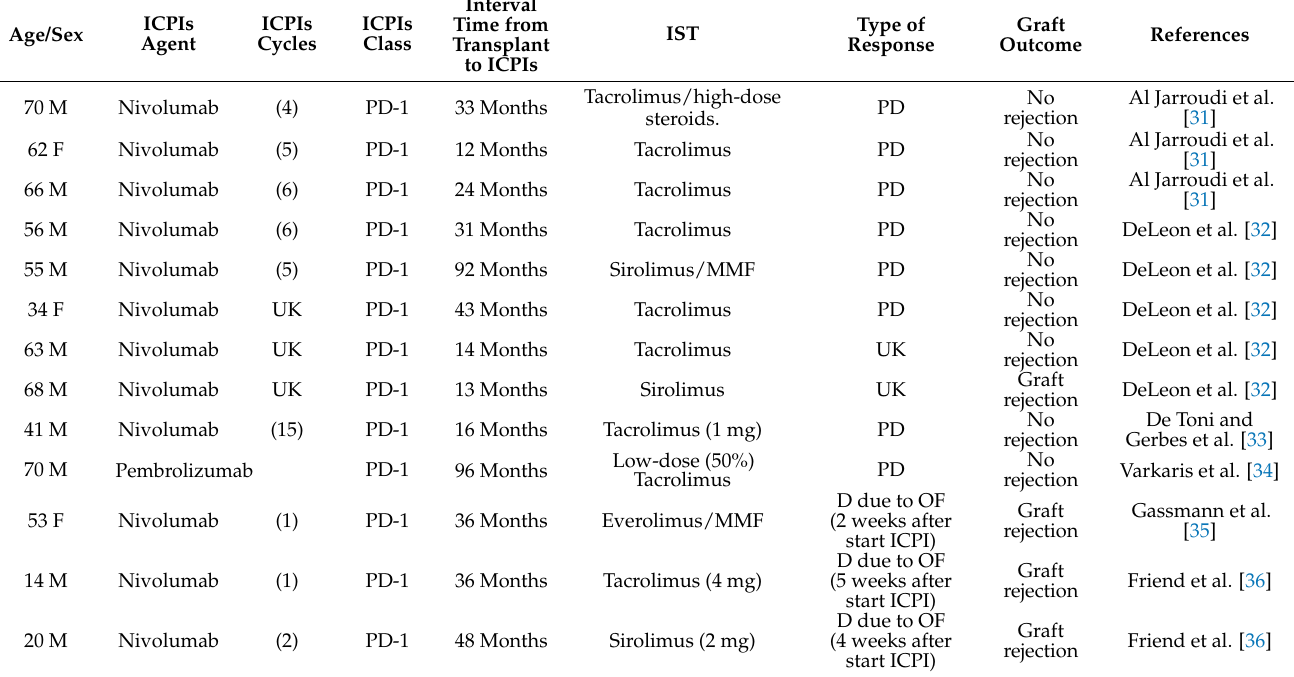
Table 1. Summary of thirteen case reports of the use of immune checkpoint inhibitors (ICPIs) in the post-liver transplant setting as palliative therapy for patients with HCC; ICPI: